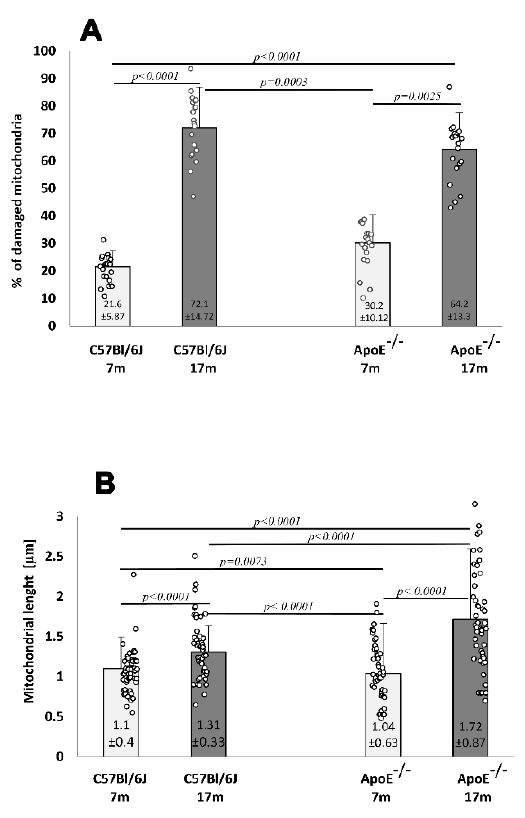
Figure 7. Senescence-related increases in damaged mitochondria and their length in the mouse hearts. The relative number of damaged cardiomyocyte mitochondria (percentage total 1000 mitochondria counts) ( A ). The average length of mitochondria in cardiomyocytes ( B ) of 7-month- and 17-month-old C57Bl/6J and ApoE − / − mice. Data were analyzed by a two-way Kruskal–Wallis test (exact F values for genotype and age in panel A are 0.01 and 134.62 and in panel B are 10.08 and 70.38, respectively) followed by a Dunn’s multiple comparison post-hoc test. Shown are the means ± standard deviations. The significance of differences between compared groups are marked with obtained p -values ( p ) for each significant comparison; the different genotype groups were not littermates, row data are depicted by circles;